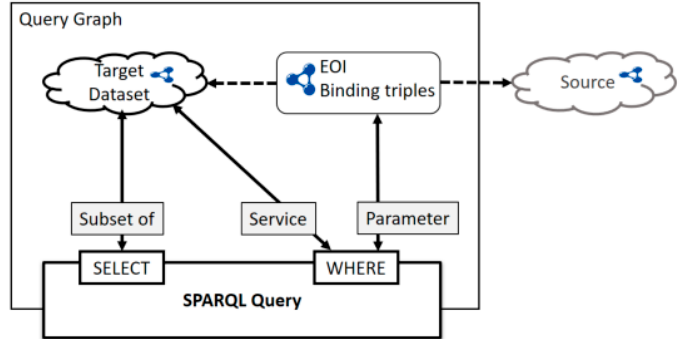
Figure 3. The SPARQL query and the query graph to obtain the augmentation content. The query graph is formed by the EOI binding triples plus the target dataset. The EOI binding triples are injected at runtime in the query graph as parameters, whereas the target dataset is included through a service (i.e., using the SERVICE clause of federated SPARQL queries). Although the source remains outside the query graph, it is possible to identify the augmentation content in the WHERE clause, using the EOI binding triples as a filter. Finally, the SELECT clause establishes which subset of the target dataset constitutes the augmented content.